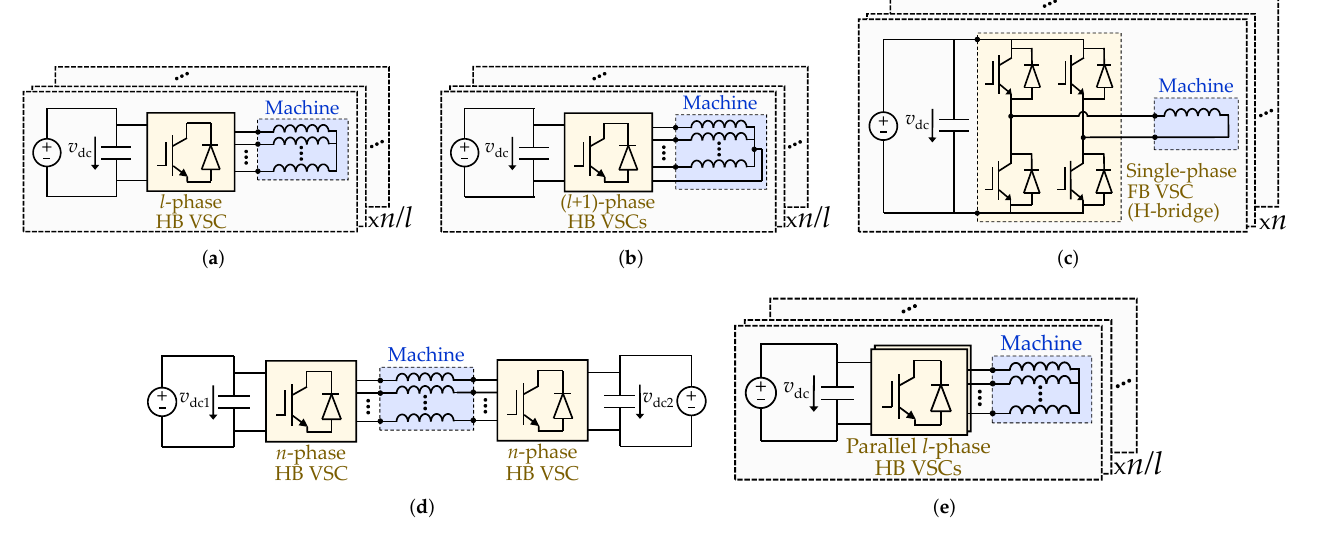
Figure 9. VSC modular topologies in multiphase ac drives, ignoring postfault reconfiguration. ( a ) Multiple independent l -phase HB VSCs. ( b ) Multiple independent ( l +1)-phase HB VSCs. ( c ) Multi- ple independent single-phase FB VSCs (H-bridges). ( d ) Dual n -phase HB VSC for open-end windings. ( e ) Multiple independent parallel l -phase HB